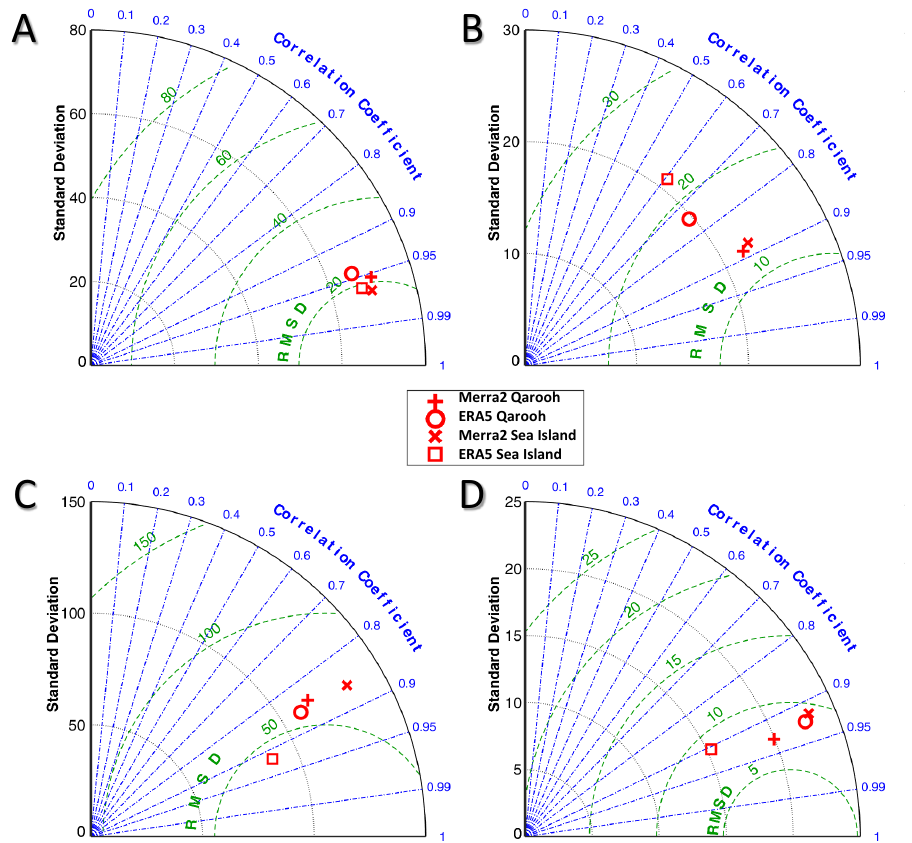
Figure 8. Taylor diagrams summarizing the results of the comparisons between reanalysis products and observations at Sea island and Qarooh Island for ( A ) shortwave radiation, ( B ) longwave radiation, ( C ) latent heat flux, and ( D ) sensible heat flux.